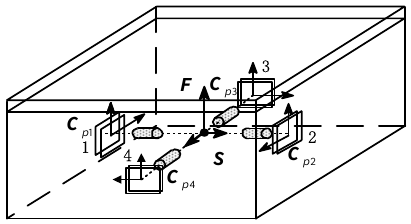
Figure 2. Schematic diagram of the installation position of PSDs and light sources.